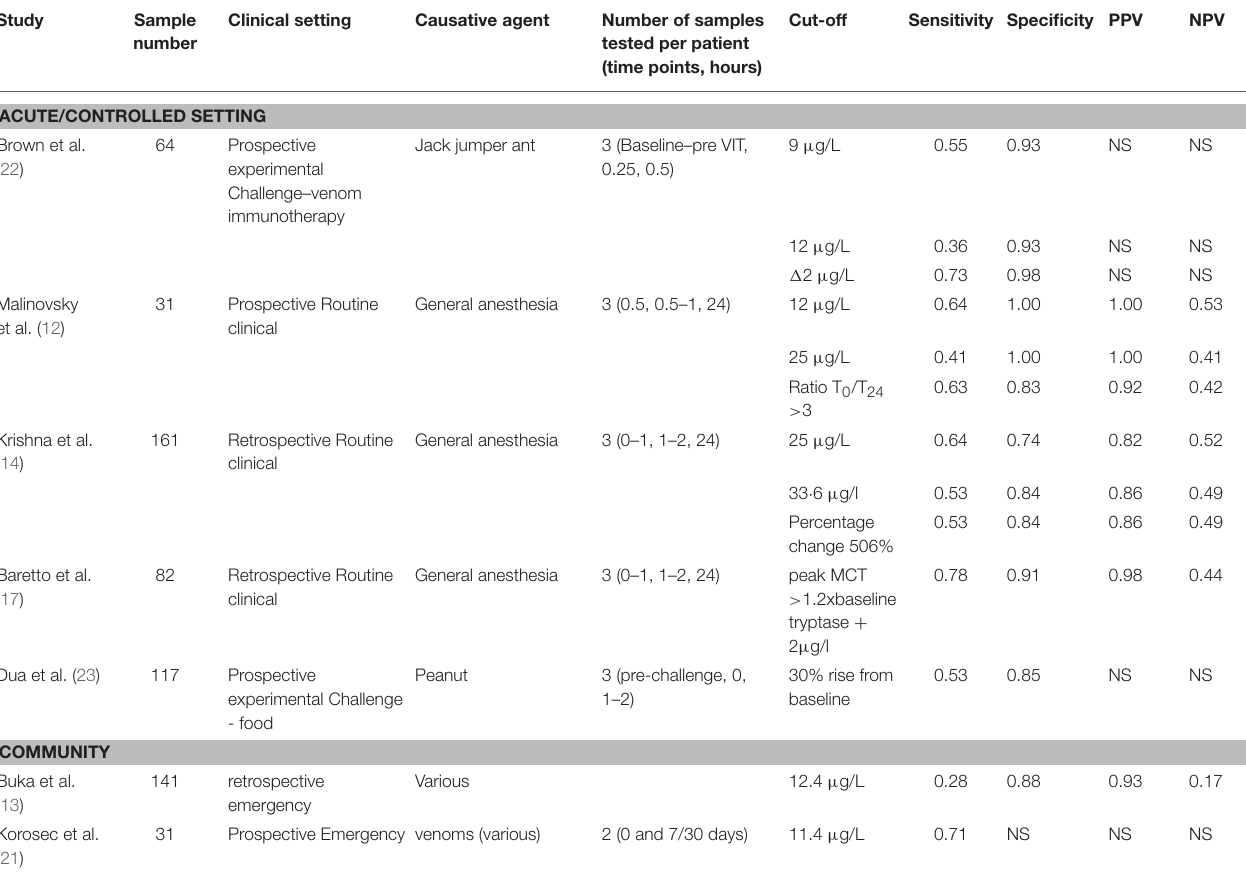
TABLE 1 | Performance of mast cell tryptase measurement in different clinical settings. Study Sample Clinical setting Causative agent Number of samples number